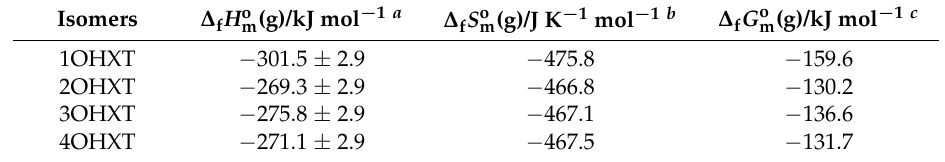
Table 6. Estimated standard gas-phase molar enthalpies, entropies, and Gibbs energies of formation,